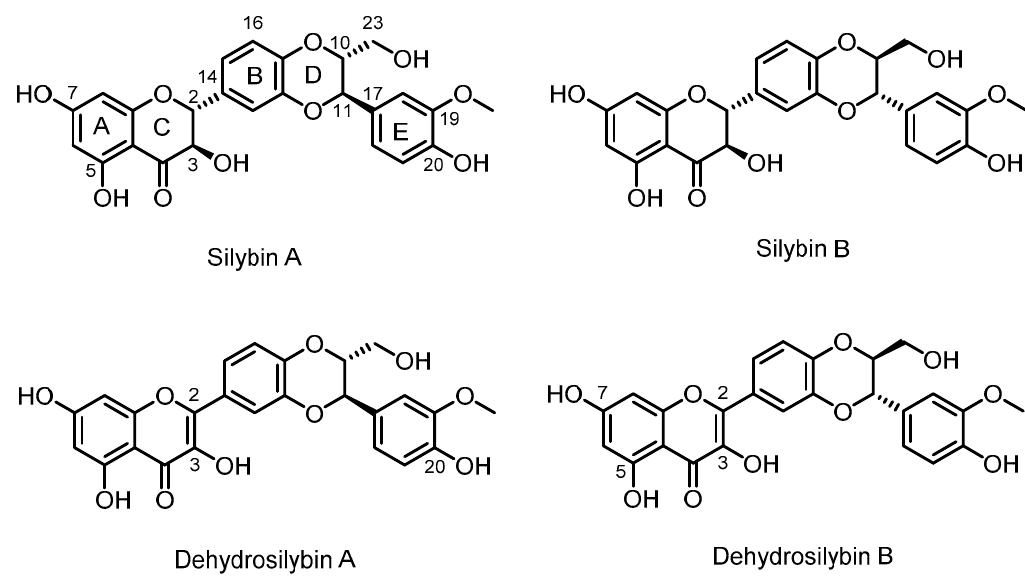
Figure 1. Structures of silybin diastereomers and 2,3-dehydrosilybin enantiomers, which occur in milk thistle.